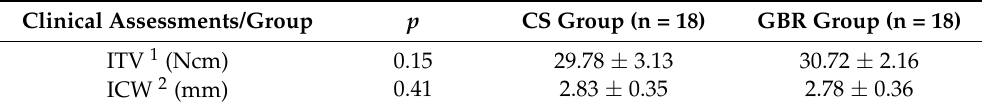
Table 2. Site-related variables.